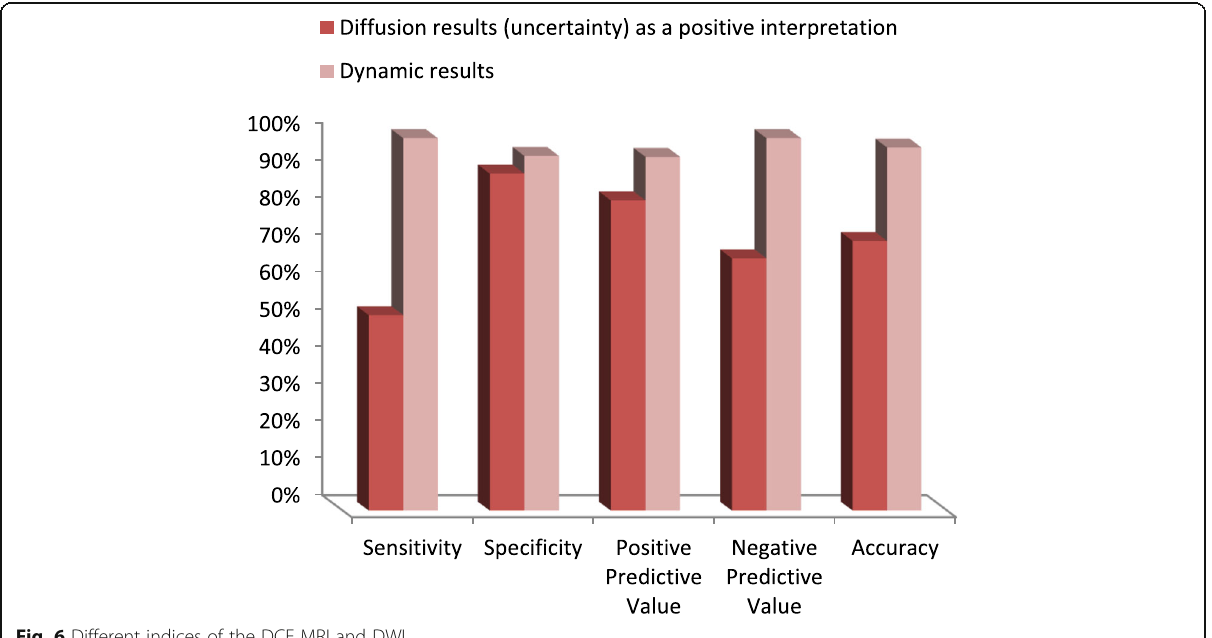
Fig. 6 Different indices of the DCE MRI and